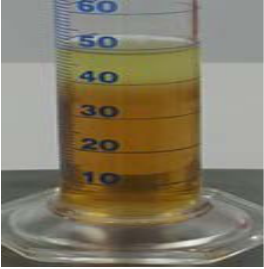
Figure 1. Gum amount in the fusel–gasoline blend.